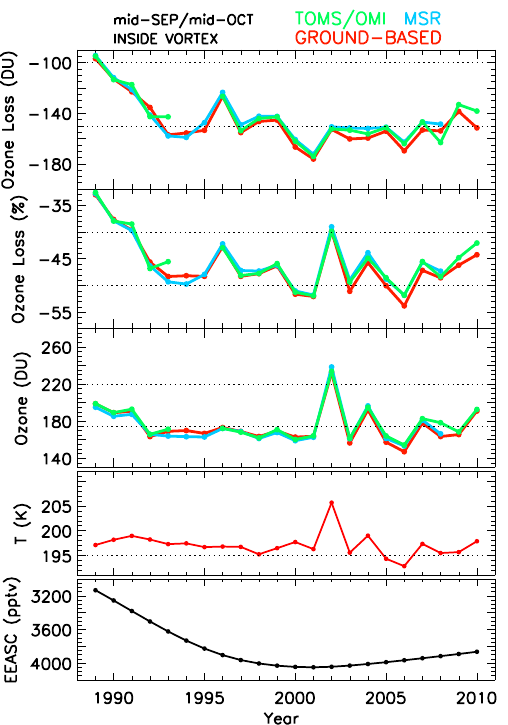
Fig. 4. The ground-based O 3 (in DU) and cumulative chemical O 3 loss (in DU and %) inside the vortex averaged between mid- September and mid-October during the Antarctic winters 1989– 2010 compared to those of TOMS/OMI (green) and MSR (blue). The corresponding vortex averaged temperature (K) at a poten- tial temperature of 475K from the ECMWF (European Centre for Medium-Range Weather Forecasts) operational analyses is also shown. The equivalent effective Antarctic stratospheric chlorine (EEASC) data are shown in the inverted scale in the bottom panel. The horizontal dotted lines represent − 100 and − 150DU of O 3 loss (top), − 40 and − 50% O 3 loss (second panel from top), 175 and 220DU of O 3 (third panel from top) and 195K temperature (fourth panel from top) in the respective